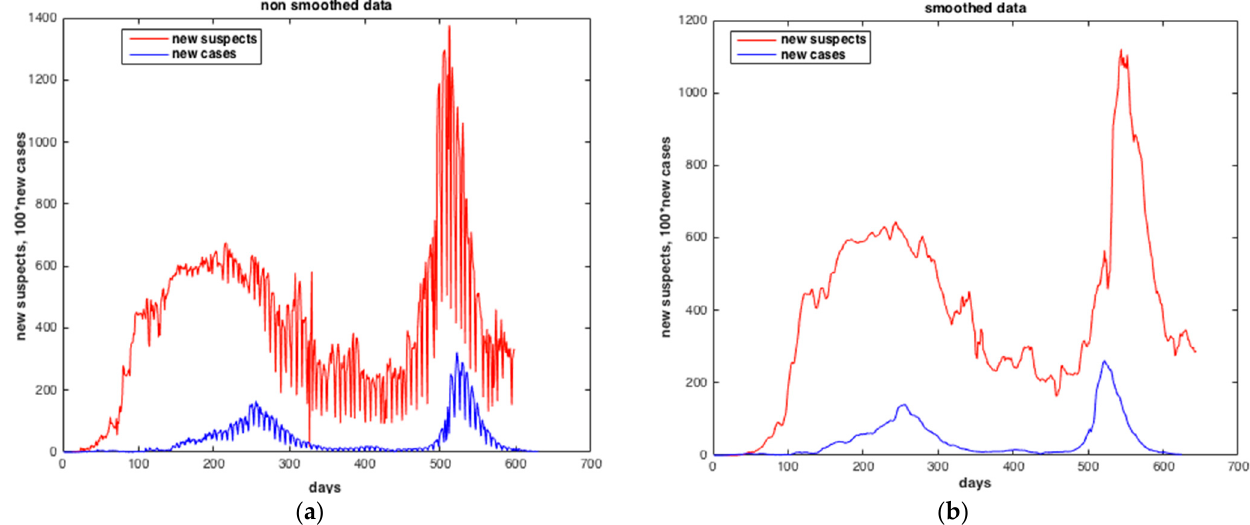
Figure 19. Comparison between the number of suspected cases and the number of infected cases. ( a ) Non-smoothed data. ( b ) Smoothed data. The results furnished by collocation method.